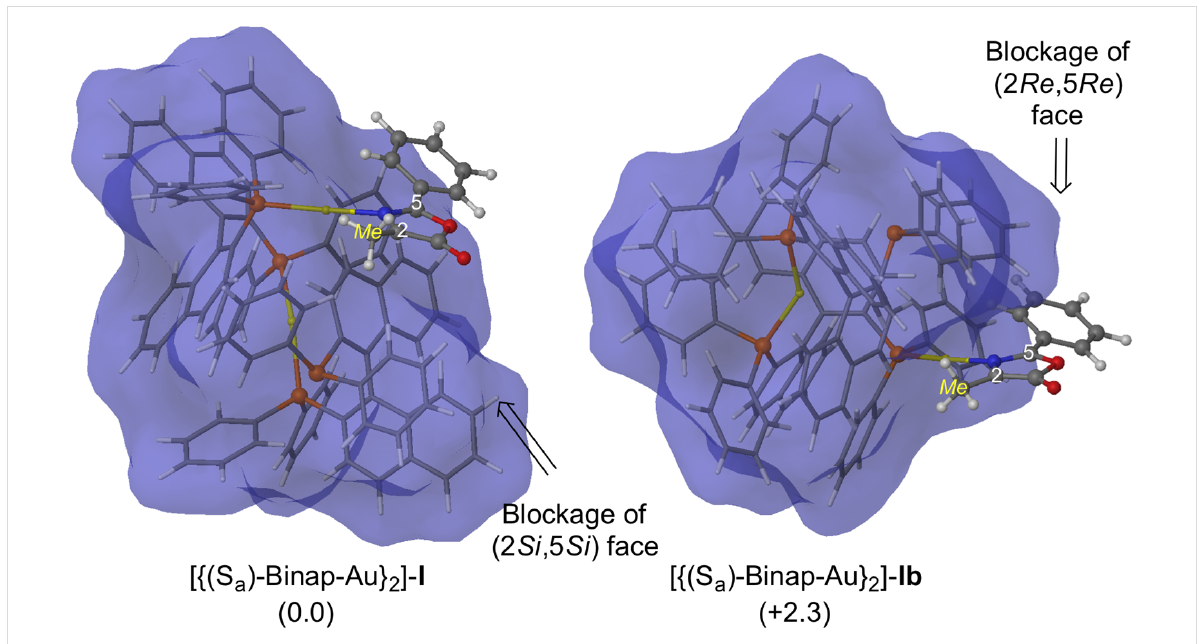
Figure 6: Main geometrical features and relative Gibbs free energies (in kcal mol − 1 at 298 K) of complexes [{( S a )-Binap-Au} 2 ]- I computed at M06/ Lanl2dz//ONIOM (b3lyp/Lanl2dz:UFF). High-level and low-level layers are represented as ball and stick and wireframe models, respectively. Blue surface represents the solvent-accessible surface with a probe radius of 1.9